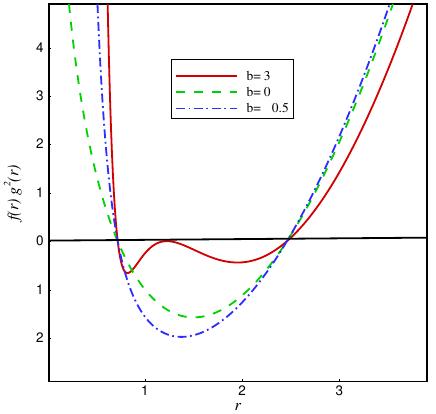
Figure 2 . The behavior of − g = f ( r ) g 2 ( r ) for charged mimetic black holes in 3D and different tt b . Here we have taken M = 2 , l = 1 , q = 1 . 5 .